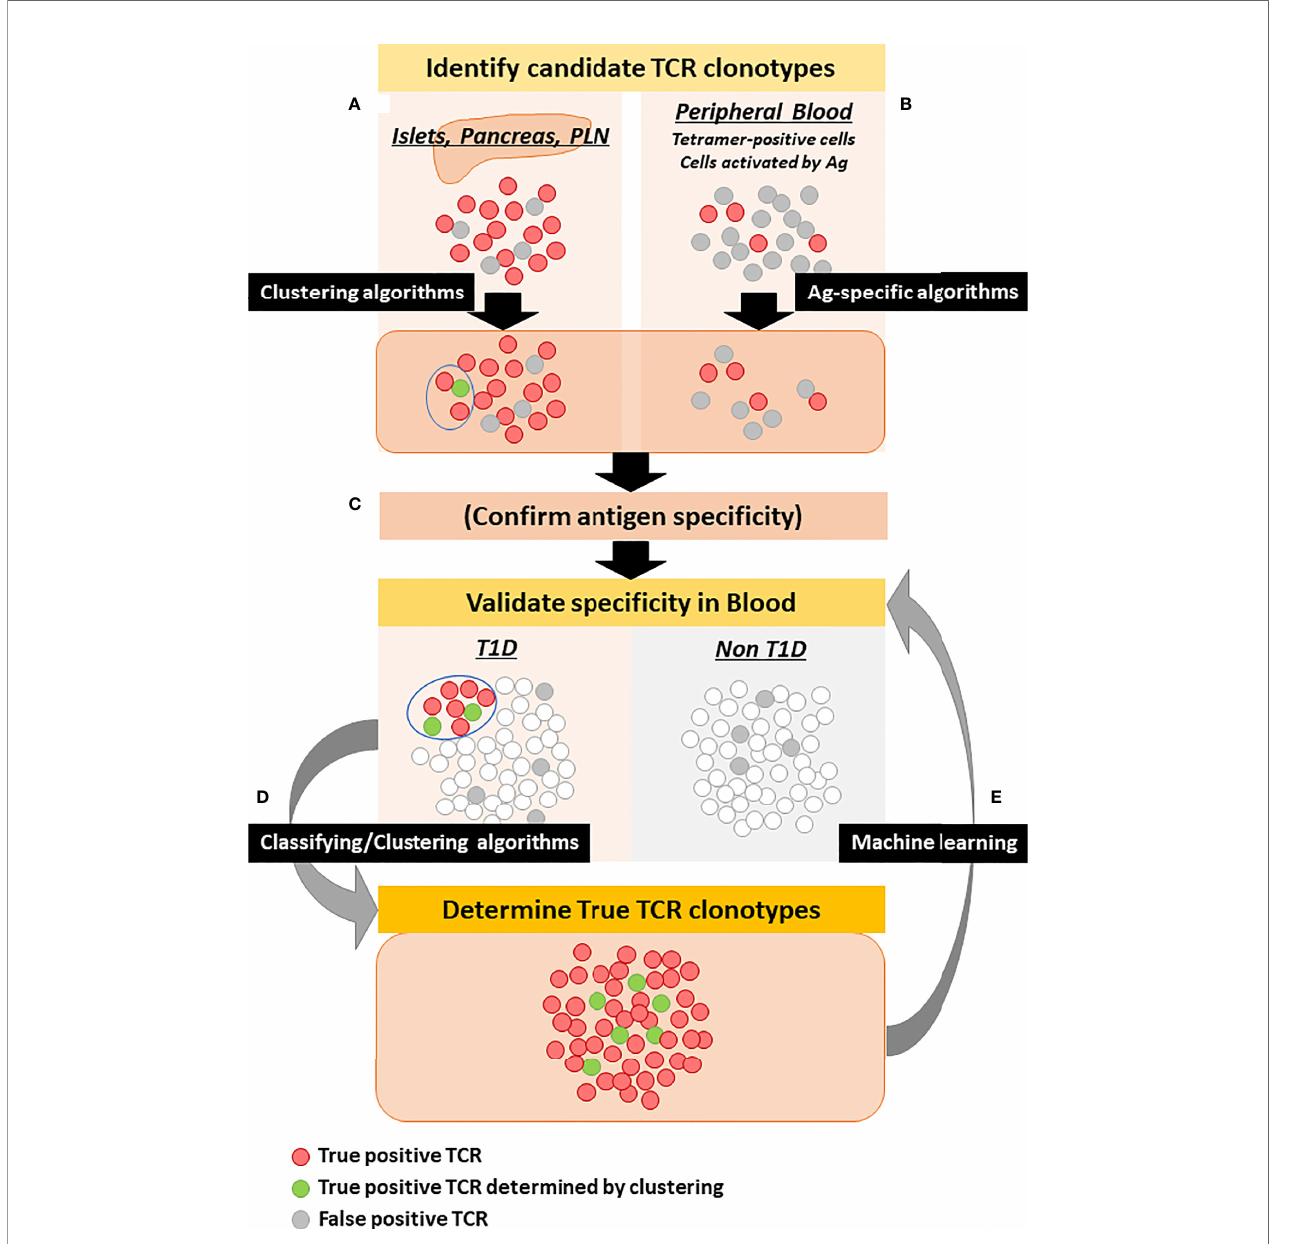
FIGURE 1 | Strategy to determine disease-speci fi c TCR clonotypes. Red and gray circles represent true and false disease-speci fi c TCR clonotypes, respectively. Green circles are true disease-speci fi c clonotypes determined by clustering with known disease-speci fi c TCR clonotypes. (A) TCRs detected in the islets, pancreata, and pancreatic lymph nodes, in particular those for which antigen speci fi city has been determined as well as those that are clustered with known disease-speci fi c TCRs, can be the initial source for disease-speci fi c TCR candidates. (B) TCRs detected from peripheral blood T cells enriched by antigen stimulation or peptide- MHC-conjugated multimers are also an initial source. Antigen-speci fi c algorithms can enrich TCR clonotypes that are truly speci fi c to antigens. (C) Candidate TCR clonotypes may be assessed for speci fi city to islet tissues, proteins, and peptides. (D) Using classifying algorithms, candidate TCR clonotypes are assessed for frequency in the blood of individuals with and without T1D to determine disease speci fi city. Simultaneously, clustering algorithms can select additional clonotypes that are clustered with known disease-speci fi c TCR clonotypes. (E) TCR clonotypes selected by classifying and clustering algorithms are used for machine learning of antigen-speci fi c algorithms to further determine true disease-speci fi